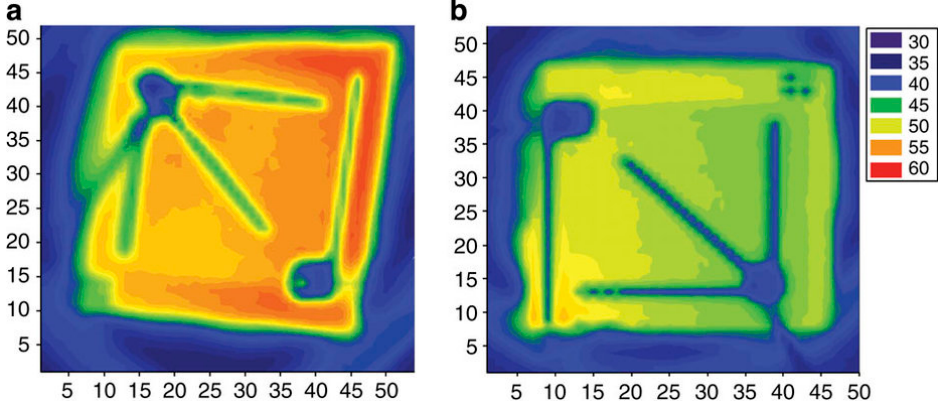
Figure 8. Infrared thermal imaging camera photographs of the chip surfaces showing the temperature distribution on the surface of ( a ) a conventional light-emitting diode (LED) chip, and ( b ) a reduced graphene oxide (rGO)-embedded chip under 100 mA current injections. Sourced from Reference [33]. Reprinted with permission from Nature Communications.